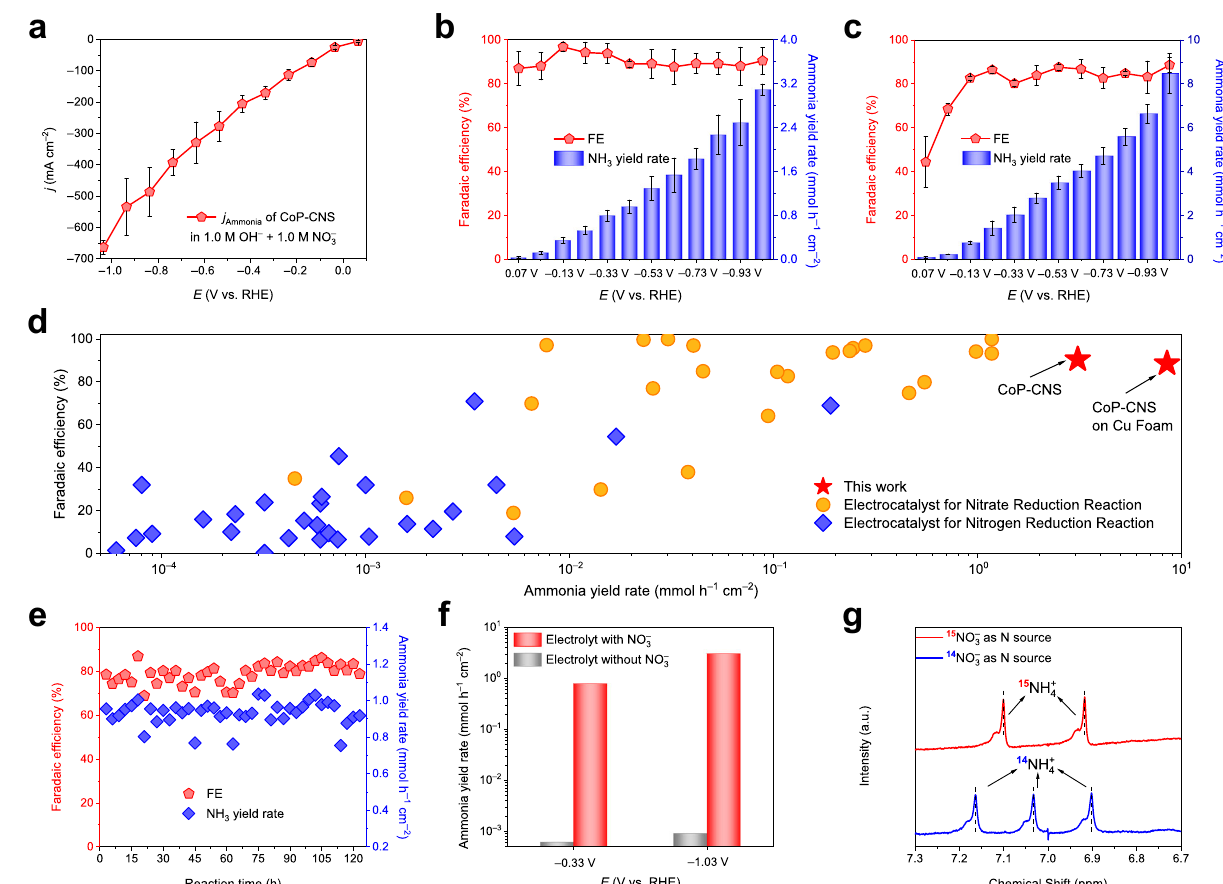
Fig.2|PerformanceofCoP-CNSfortheelectrocatalyticNITRRtoproduceNH3. a NH 3 partial current densities ( j Ammonia ), b NH 3 FEs, and corresponding yield rates ofCoP-CNSateachgivenpotentialfrom0.07to − 1.03Vvs.RHEestimatedbythree independenttests. c NH 3 FEsandcorrespondingyieldratesofCoP-CNSonCufoam underpotentialrangefrom0.07to − 1.03Vvs.RHEestimatedbythreeindependent tests. d Comparison of the electrocatalytic NITRR to NH 3 performanceof CoP-CNS with those of other reported electrocatalysts for NH 3 production. e NH 3 FEs